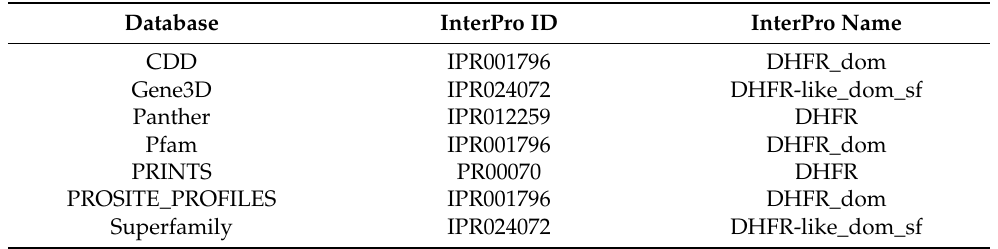
Table 3. InterProScan database hits on DLP1 and DLP2 DHFR. The data represent findings for both phages due to identical search results.